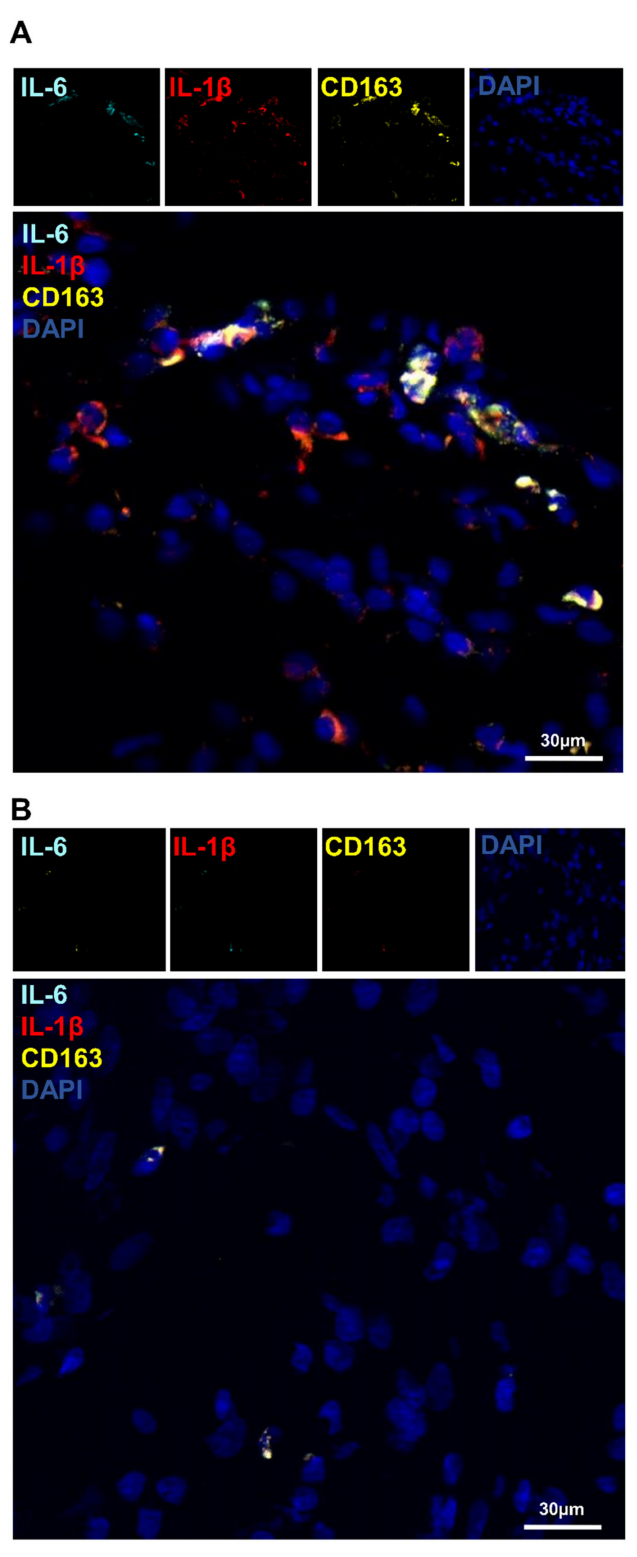
Figure 10. Identification of the M2b-like macrophages in the operated femur by in situ hybridiza- tion combined with hybridization-chain-reaction detection (in situ HCR): ( A ) in situ hybridization combined with hybridization-chain-reaction detection (in situ HCR); ( B ) negative control: Probe-IL-6 (Alexa488, turquoise fluorescence), Probe-IL-1 β (Alexa546, red fluorescence), Probe-CD163 (Alexa647, yellow fluorescence), nuclear staining with DAPI (blue